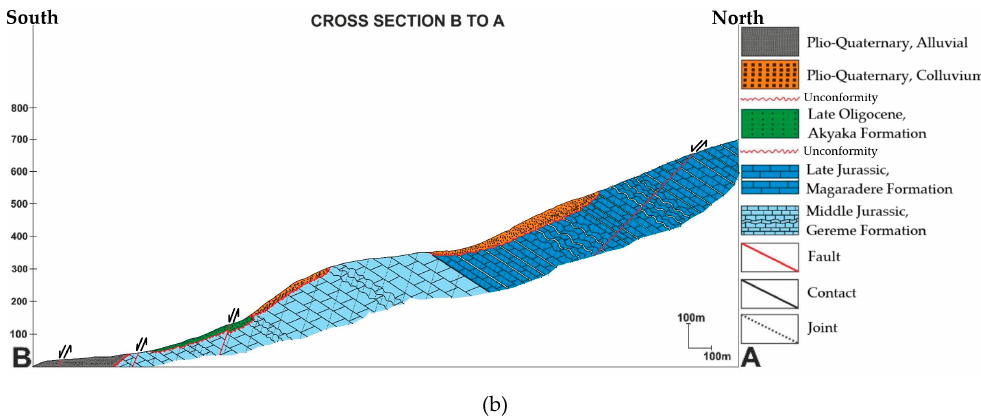
Figure 2. The geology around the study area: ( a ) geological map of the broader study area; ( b ) geological section from B (South) to A (North) as depicted in the geological map.